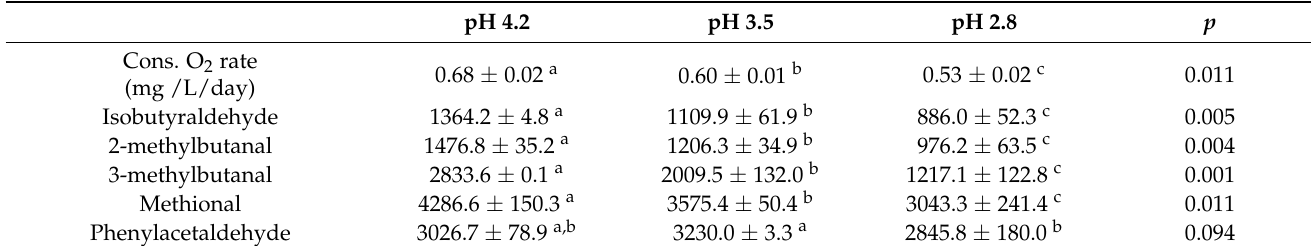
Figure 1. ( a ) Correlation between accumulation rate ( μ g/L/day) of methional and pH. Blue dots correspond to white and rosé wines. The 8 reds are represented in orange; ( b ) correlation between total accumulation ( μ g/L) of methional and oxidation time. Blue dots correspond to white and rosé wines. The 8 reds are represented in orange. Table 4. Averages and standard deviation ( n = 2) of consumed oxygen rate (mg/L/day) and Strecker aldehydes concentrations ( µ g/L). Different letters indicate significant differences ( p < 0.05) (Fisher post hoc